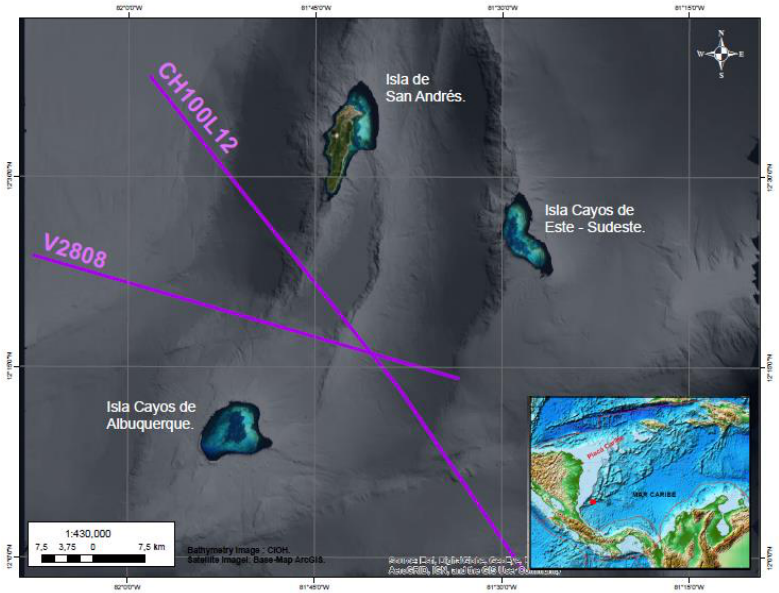
Figure 12. Tracking line chart of oceanographic cruises that acquired geomagnetic data in 1970 and 1971.